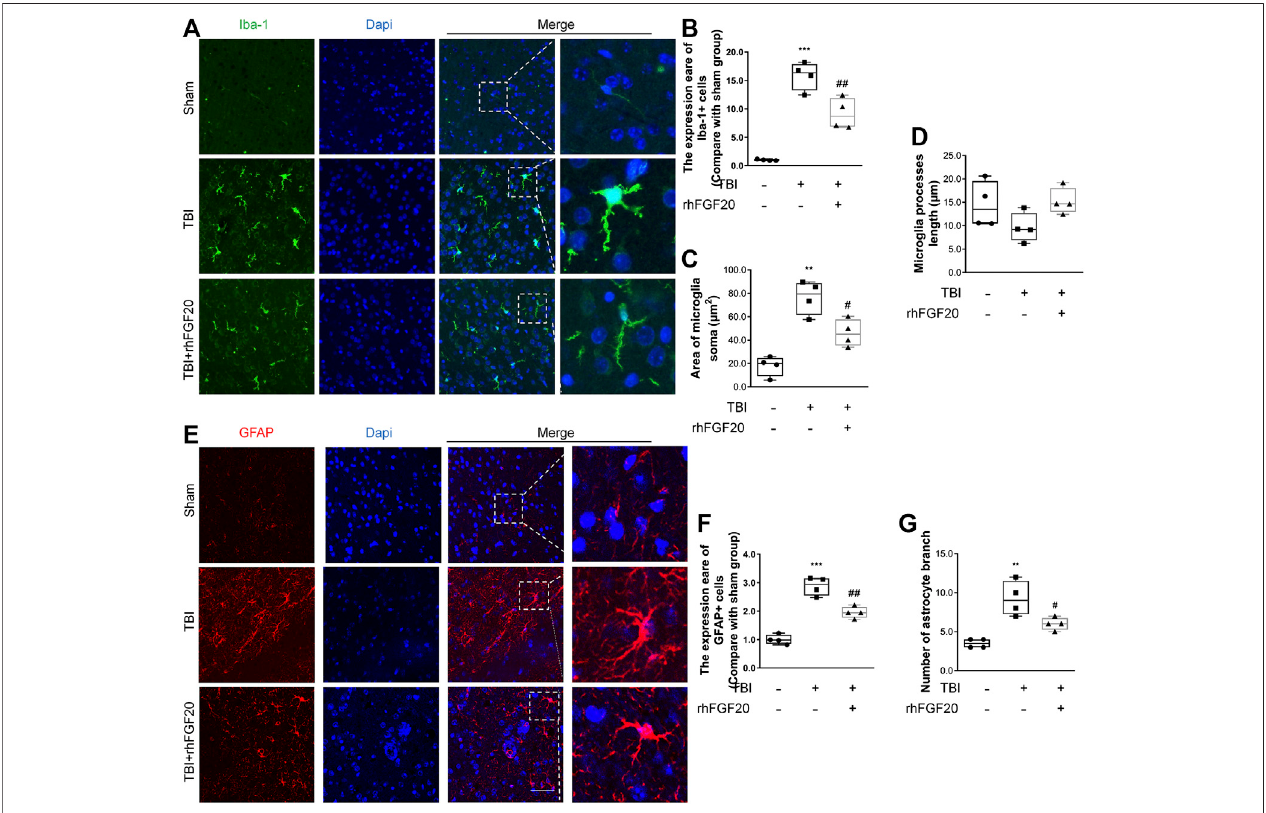
FIGURE4| ExogenousrhFGF20inhibitedneuroin fl ammationinthemousebrain24 hafterTBI (A) Representativeimagesofmicroglialactivation.Nucleiarelabeled with DAPI (B – D) Quanti fi cation of immuno fl uorescence staining data showing the expression of Iba-1-positive microglial, microglial Soma area and microglial process length ( n (cid:1) 4) (E) Representative images of astrocytes activation. Nuclei are labeled with DAPI (F – G) Quanti fi cation of immuno fl uorescence staining data showing the expression of GFAP-positive astrocytes, and astrocytes branches number ( n (cid:1) 4). Bar, 50 μ m ** p < 0.01, *** p < 0.001 vs. sham group. # p < 0.05, ### p < 0.001 vs. TBI group. Data are presented as the mean values ±